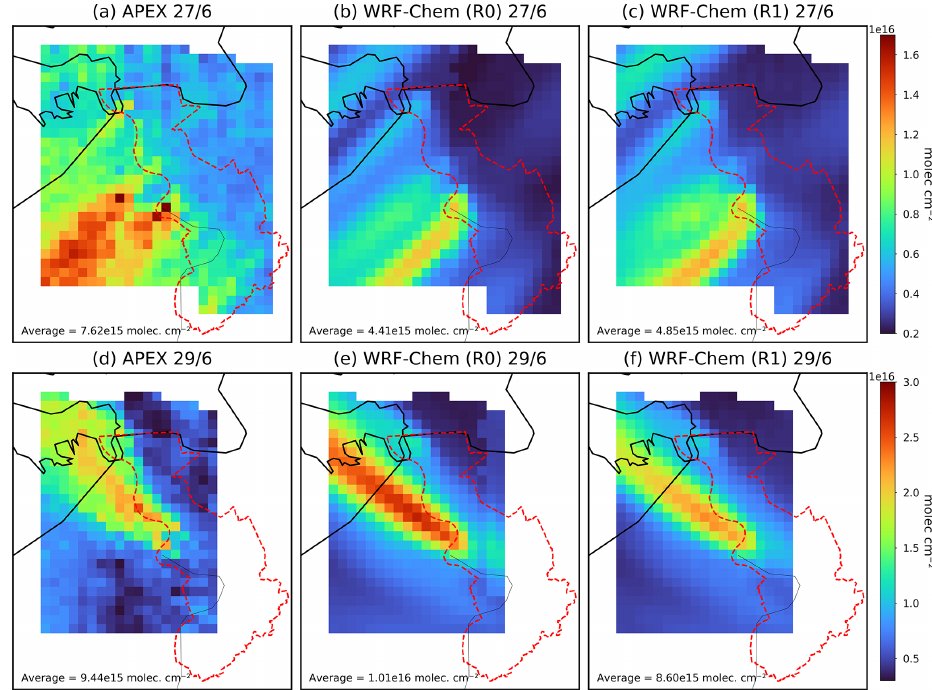
Figure 18. APEX and corresponding WRF-Chem NO 2 distribution on 27 (a–c) and 29 (d–f) June 2019. The APEX data were regridded onto the 1 × 1km 2 model grid. The red dashed outline represents the region of the municipality of Antwerp. Measurements are shown in the leftmost column, while the middle and right columns display the modeled columns obtained from simulations R0 and R1. The average column value is shown in each panel.